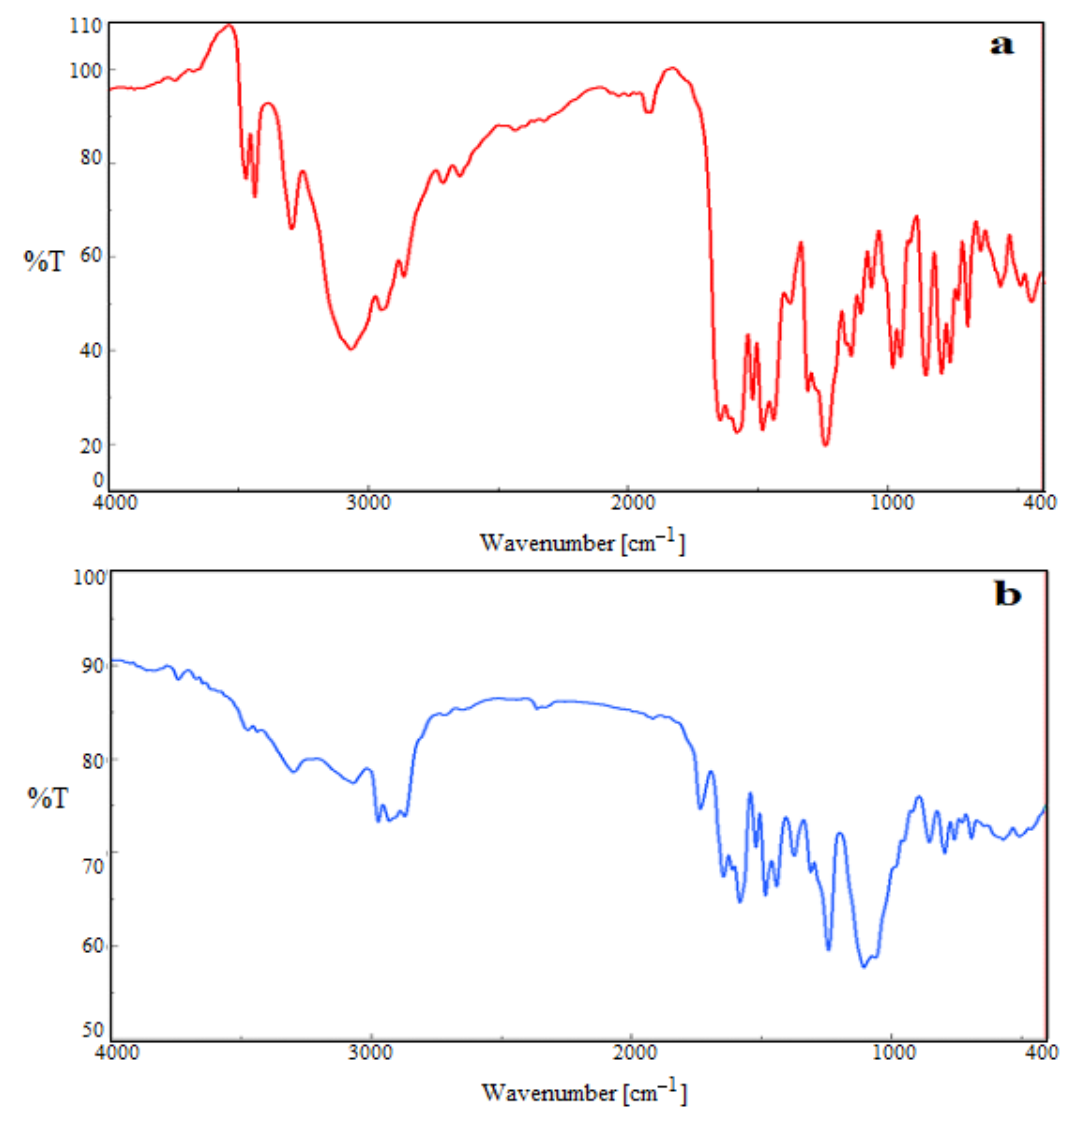
Figure 3. FTIR spectra of pure ibrutinib ITB ( a ), and IBNS4 ( b ).